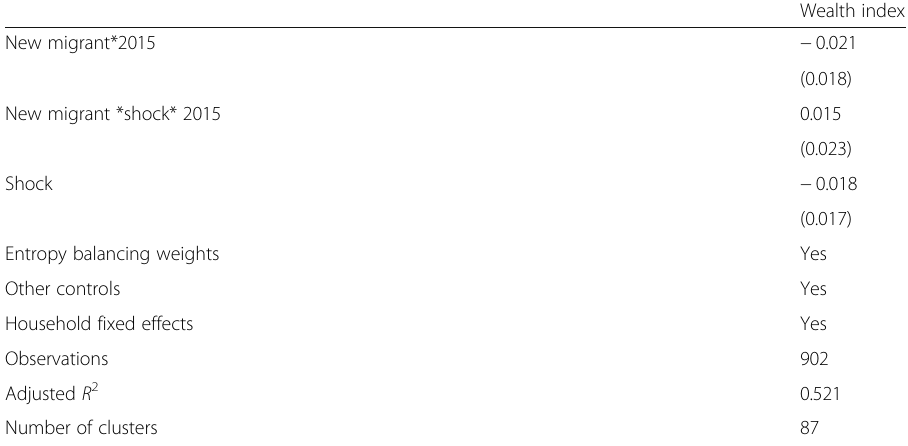
Table 10 Effect of new migrant on household welfare controlling for major shocks in